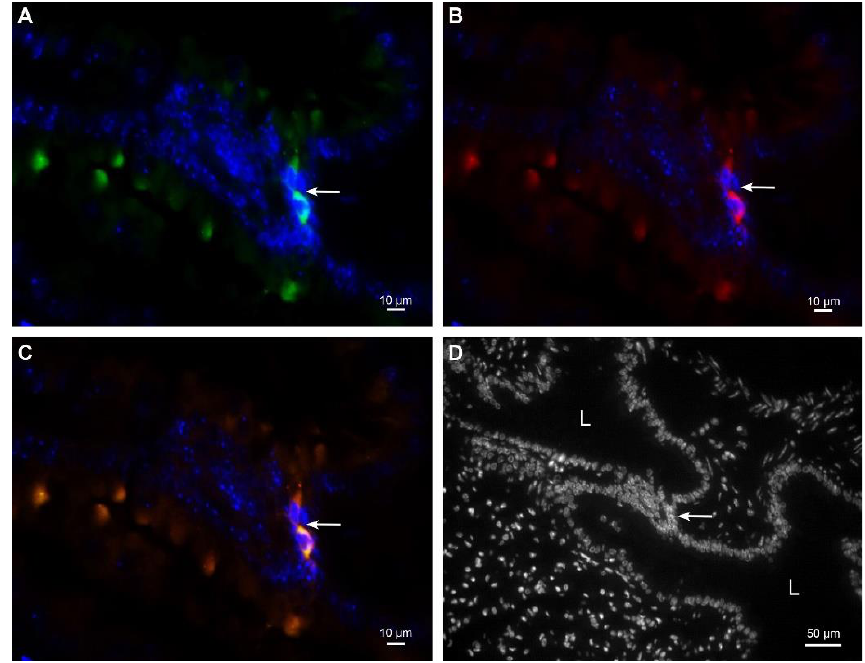
Figure 4. Representative images of immunofluorescent labeling against CD44 and CD105 in lungs. Two MSCs with positive immunoreaction against CD44 (green fluorescence) ( A ) and CD105 (red fluorescence) ( B ). The same two MSCs are orange−colored due to merged green fluorescence of CD44 and red fluorescence of CD105 confirming the colocalization of both surface markers ( C ). MSCs were located in the interstitium between alveoli (( D ) nuclear staining only). Nuclei are stained with DAPI. Arrow denotes two MSCs. L−lumen of the alveolus.